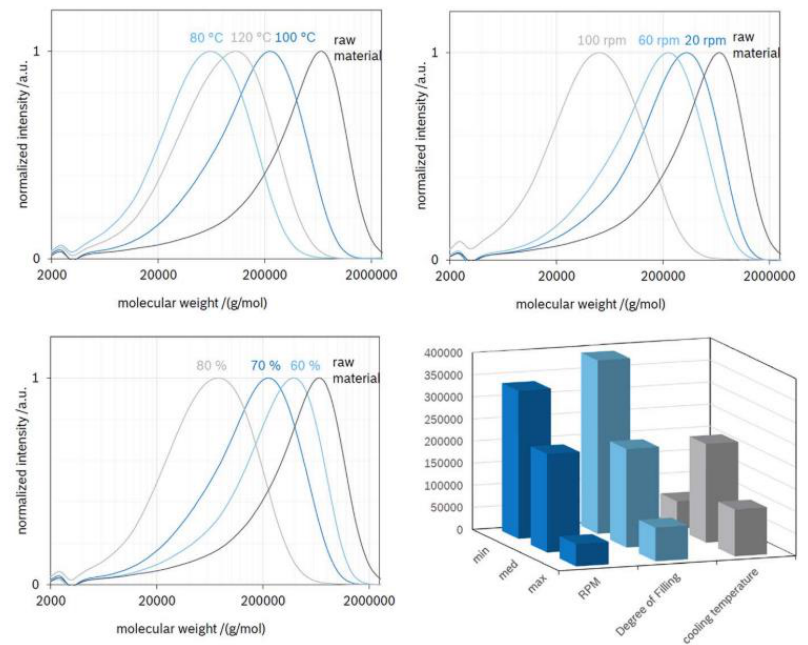
Figure 7. Impact of temperature (top left), shear rate (top right) and filler content (bottom left) during extrusion process of PEO. The chain lengths of PEO are analyzed by GPC and a summary of the impact of three parameters mentioned is made in bottom right corner. Reprinted with the permission of Journal of The Electrochemical Society, 2020, 167, 020558 [50].